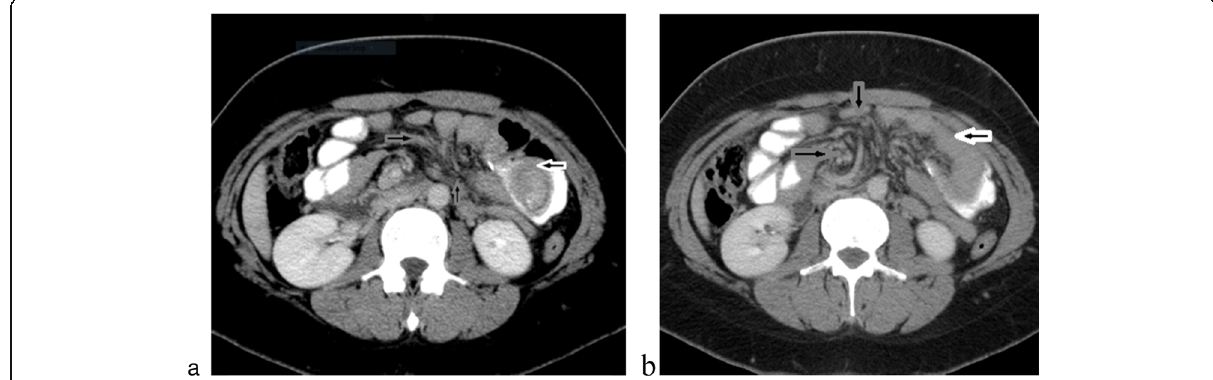
Fig. 5 A thirty-nine-year-old male patient presented 2 years post-Roux-en-Y gastric bypass by abdominal pain and vomiting. a , b Axial MSCT shows dilatation of some of the proximal jejunal loops with a mild thickened wall (white arrow) associated with a right para-central whirling appearance of the mesenteric structures (gray arrow), below the origin of the superior mesenteric artery. Diagnosis: internal hernia with proximal bowel obstruction